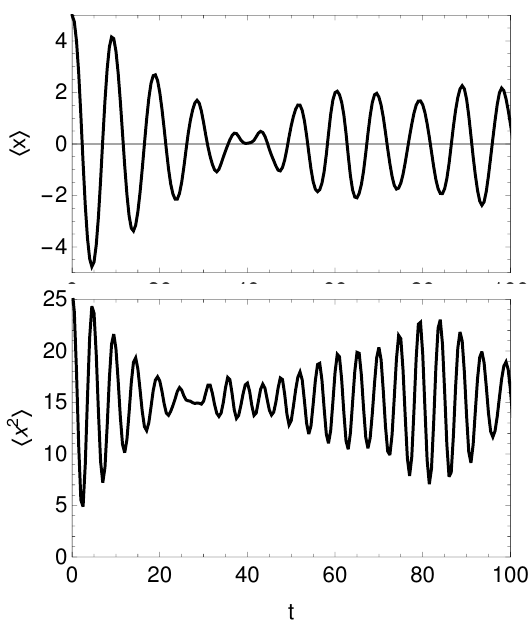
Figure 4 . Expectation value of x and x 2 of a wave packet as a function of time moving in a V shaped potential (2.1) with u = 1 . The initial wave packet is Gaussian (3.3) with x